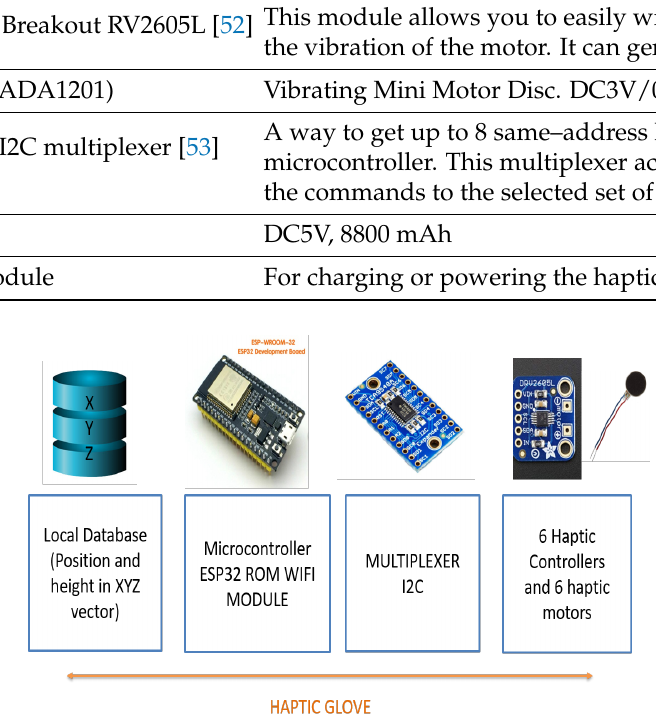
Figure 6. General diagram of the haptic glove